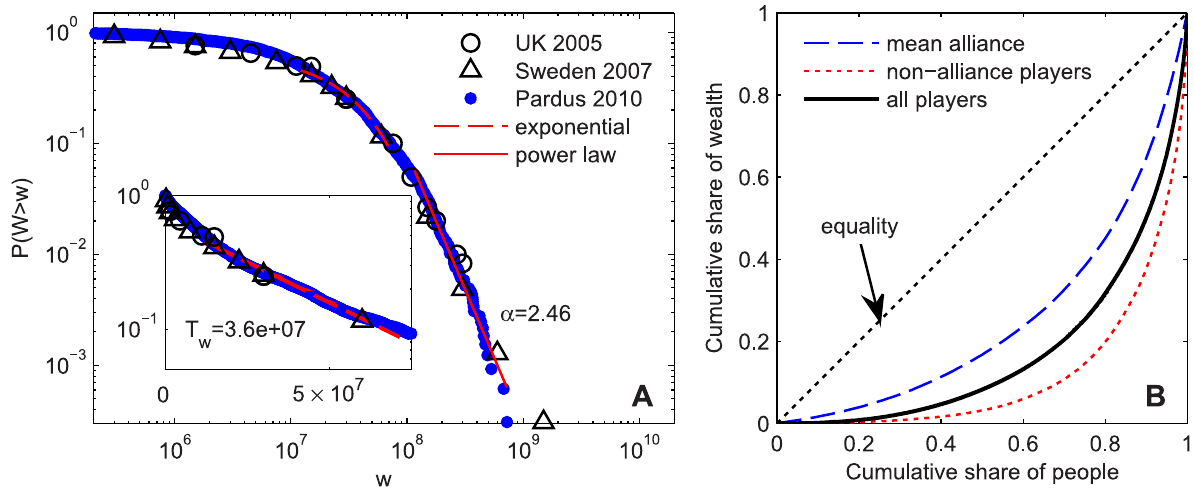
Figure 1. Wealth distribution and Lorenz curve. A Cumulative wealth distributions for the United Kingdom, Sweden, and for the Pardus MMOG on day 1200. (Data sources: [29,31]) People with negative wealth have been excluded. A power-law tail is visible. The exponent is determined with a least-square fit to the richest 5% of the population. The bulk of the distribution, i.e. the richest 50% to 10%, can be fitted with an exponential function P ( W w w ) ! exp( w = T w ) (inset). The poorest obviously do not follow an exponential distribution, while the richest 10% are the crossover region to a power-law. B Lorenz curve of wealth in Pardus on day 1200 (excluding newcomers and inactive players). For every alliance, a separate Lorenz curve is calculated. The dashed blue curve represents the average of these single alliance Lorenz curves.